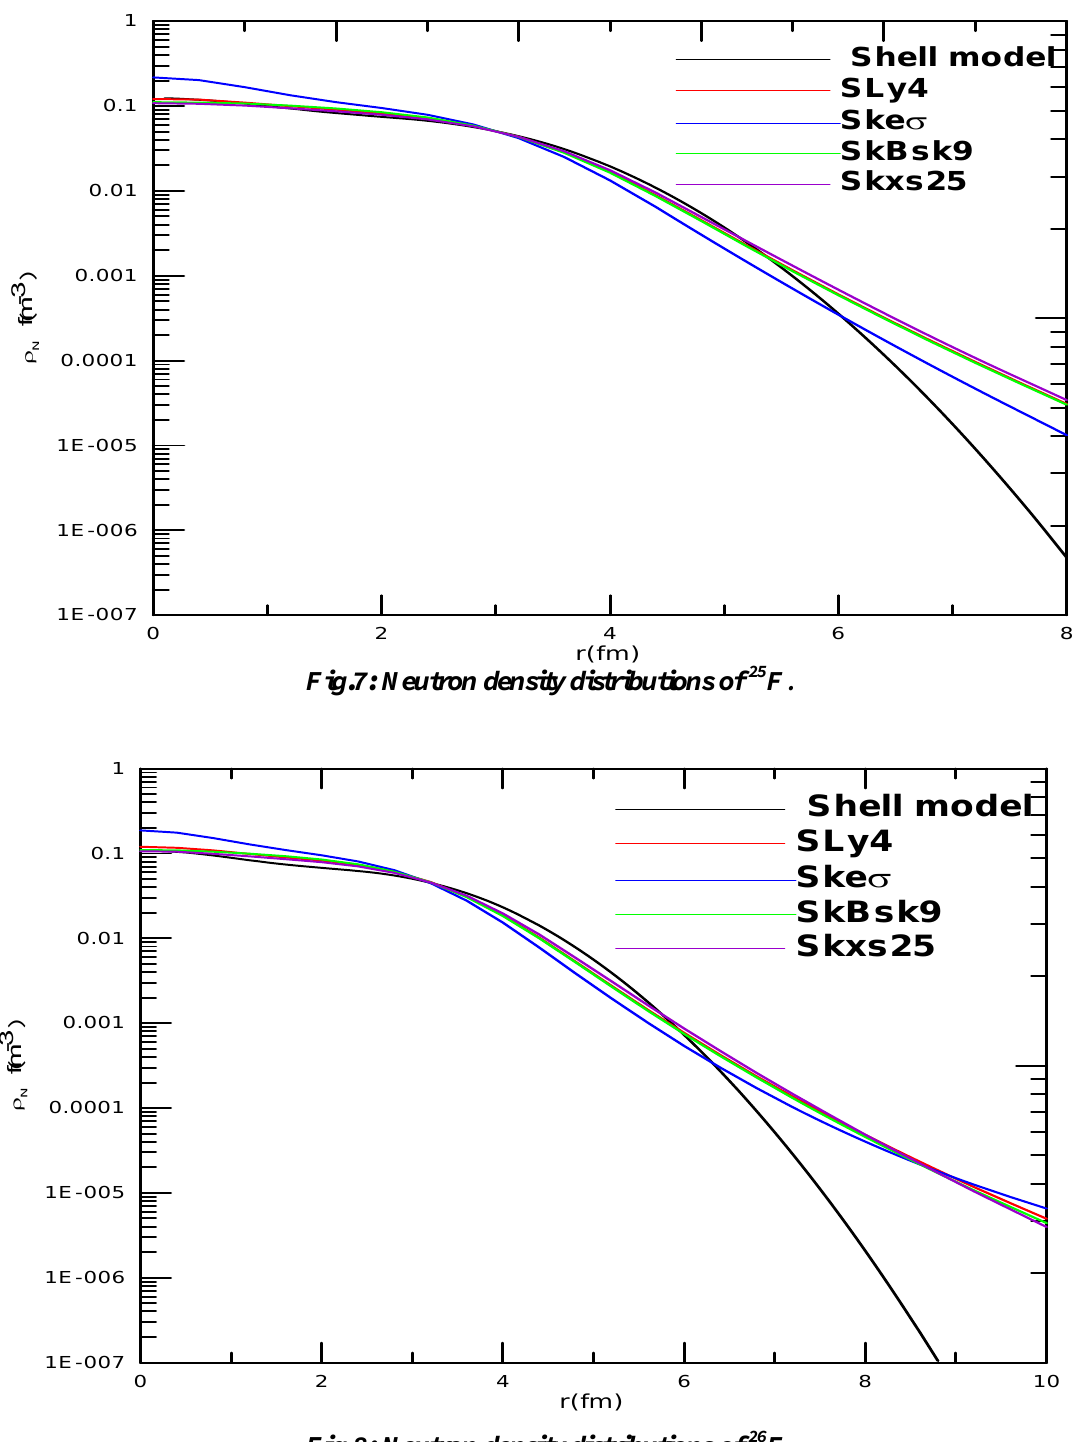
Fig.8: Neutron density distributions of 26